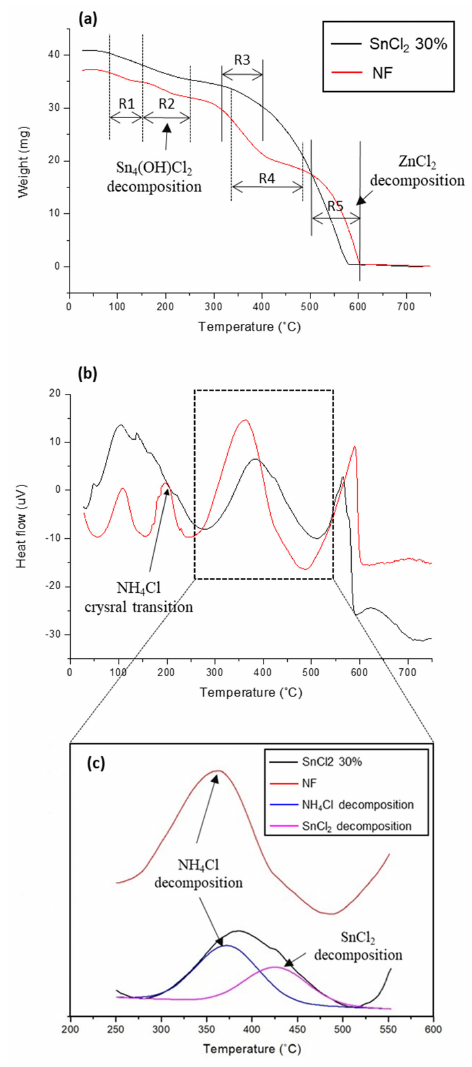
Figure 6. ( a ) TGA and ( b ) DTA curves showing the thermal decomposition behavior of the fluxes for Figure 6. (a) TGA and (b) DTA curves showing the thermal decomposition behavior of the fluxes for high ‐ quality coatings with improved adhesion. (c) Deconvolution of the SF30 DTA curve. high-quality coatings with improved adhesion. ( c ) Deconvolution of the SF30 DTA